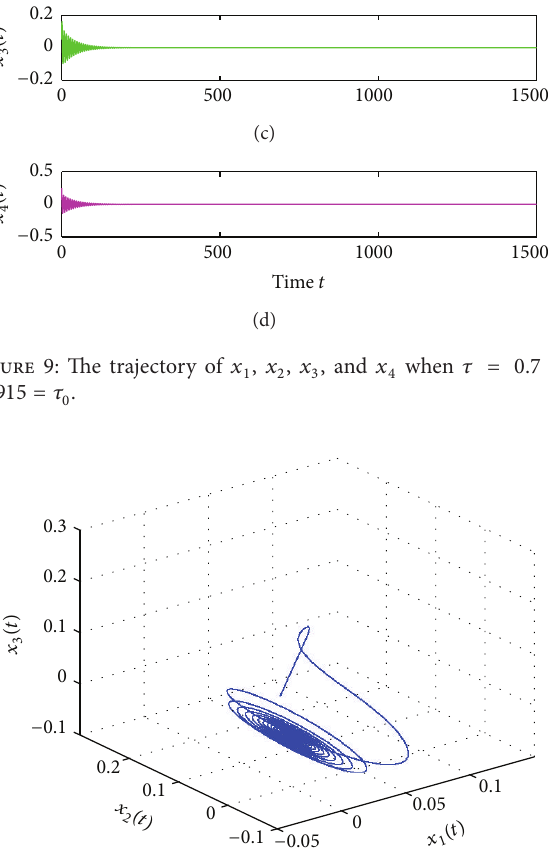
Figure12:Thephaseplotof 𝑥 1 , 𝑥 2 ,and 𝑥 3 when 𝜏 = 0.85 > 0.7915 = 𝜏 0